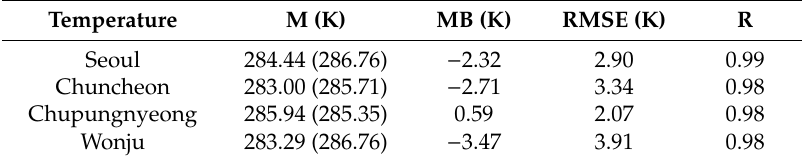
Figure 6. Correlation between Weather Research and Forecasting (WRF) model and weather station measurements of solar radiation, at: ( a ) Seoul; ( b ) Chuncheon; ( c ) Chupungnyeong; and ( d ) Wonju. Table 7. Temperature mean (M), mean bias (MB), root-mean-square error (RMSE), and Correlation Coe ffi cient (R) between the Weather Research and Forecasting (WRF) model and weather station